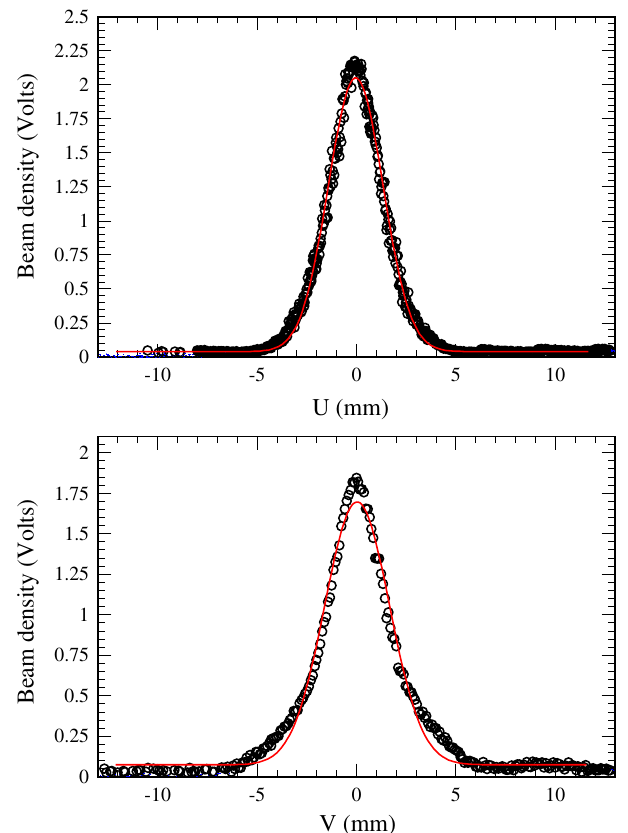
FIG. 3. (Color) Transverse profiles of the injection beam mea- sured by MWPM4 with two wire sensor frames, where the wires are put parallel to the U and Vaxes 17.7 degrees rotated from the horizontal and vertical axes on the transverse two-dimensional plane. Therefore the beam profiles in this figure are given as the projections to the U and V axes. Solid red curves are Gaussian fitting